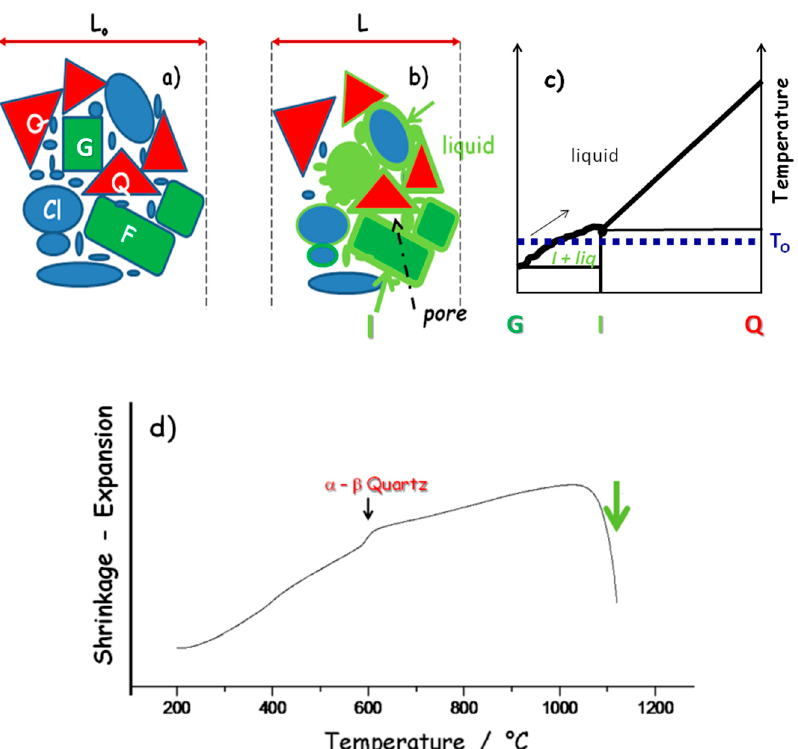
Figure 2. Schematic of liquid-phase sintering of a heterogeneous green ceramic body: ( a ) compacted grains (green state); ( b ) reaction sintering, with the molten phases noted in light green; ( c ) diagram of the G–Q phase vs. temperature; ( d ) plot of the dilatometric behavior during liquid sintering, where the event at 573 °C corresponds to the α – β phase transition of SiO 2 quartz grain and the large green arrow indicates the temperature at which a molten phase is formed.